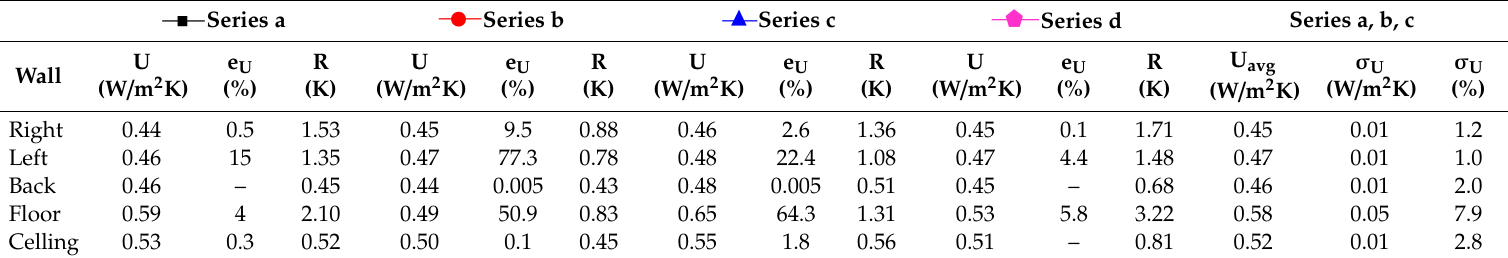
Table 6. Opaque walls. U value. Summary of the results using models that do not include solar radiation. Output: T i . Where e g is the error and R is the average of the residuals given by LORD for each data series.